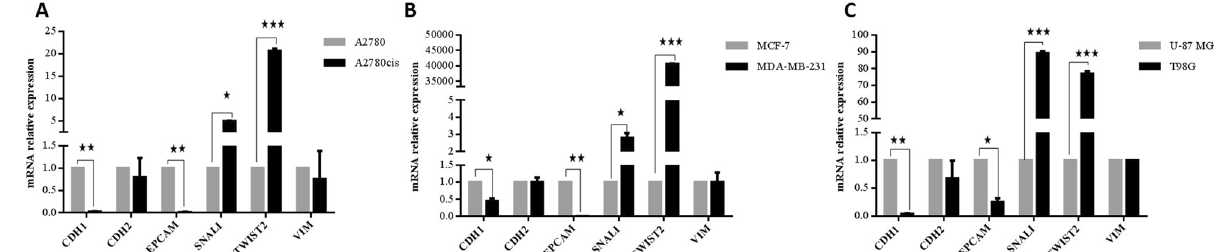
Figure 6. Resistant cancer cells display molecular changes consistent with partial EMT. Down-regulation in epithelial genes: CDH1 and EPCAM , and up-regulation in mesenchymal marker SNAIL and TWIST2 , were assessed using qPCR, no significant expression changes in CDH2 and VIM genes were observed. ( A ) A2780cis compared to parental cells A2780. ( B ) MDA-MB-231 cisplatin resistant cells compared to MCF7 cisplatin sensitive cells. ( C ) T98G cisplatin resistant cells compared to U-87 MG the more sensitive cisplatin